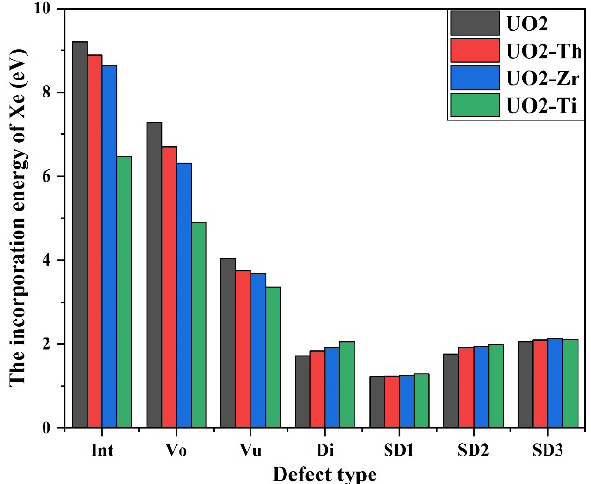
Figure 3. Incorporation energy of Xe at different defect type positions and the effect of dopant on its incorporation energy.